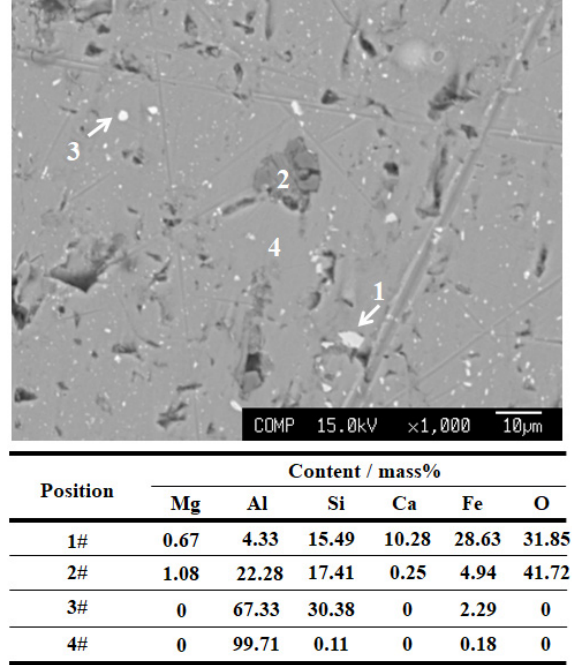
Figure 4. Microstructure of Al (lump).